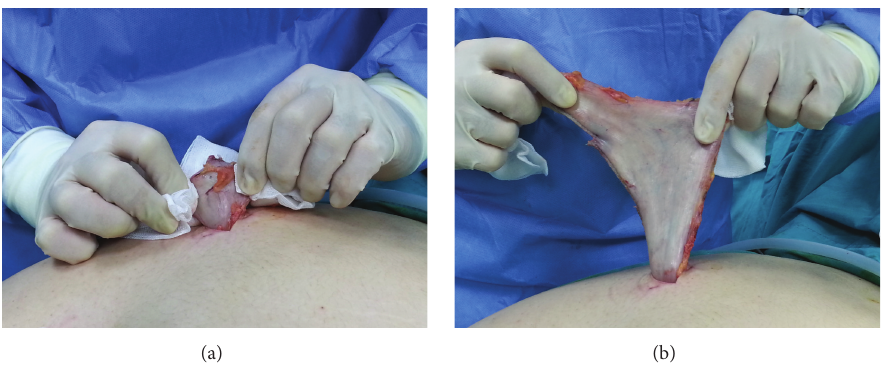
Figure 2: Extraction of the entire specimen via the 15mm trocar site by gauze